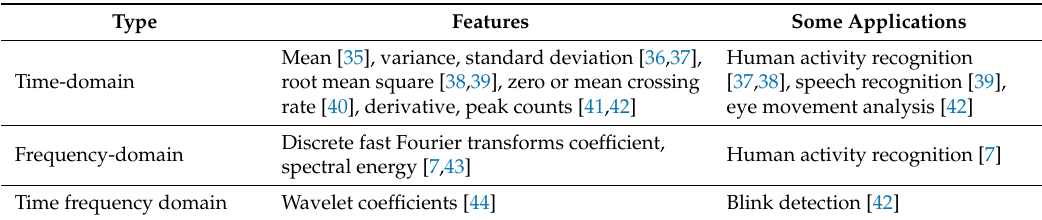
Table 1. Some of the most widely used features as discussed in